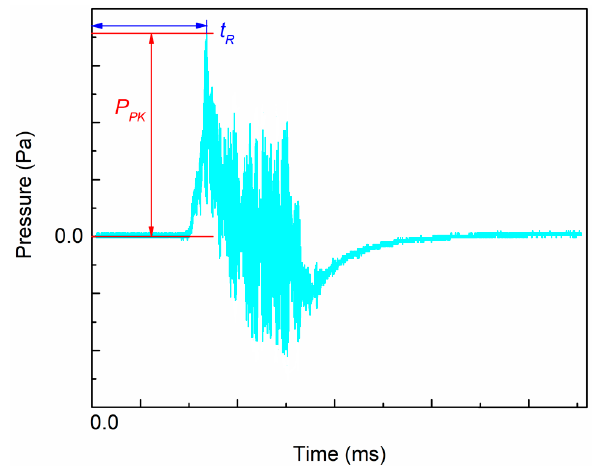
Figure 1. Schematic diagram of peak pressure and peak pressure arrival time at a measuring point.